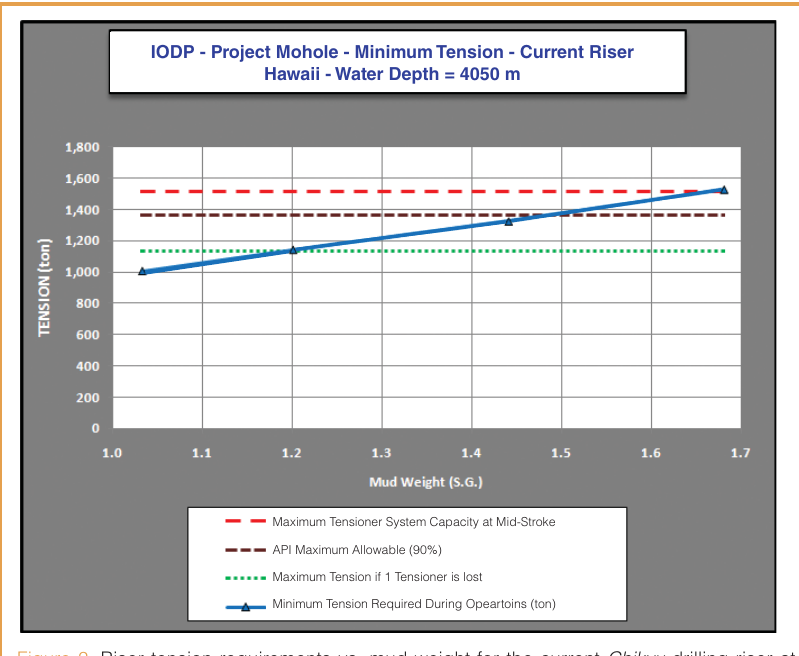
Maximum Tensioner System Capacity at Mid-Stroke API Maximum Allowable (90%)